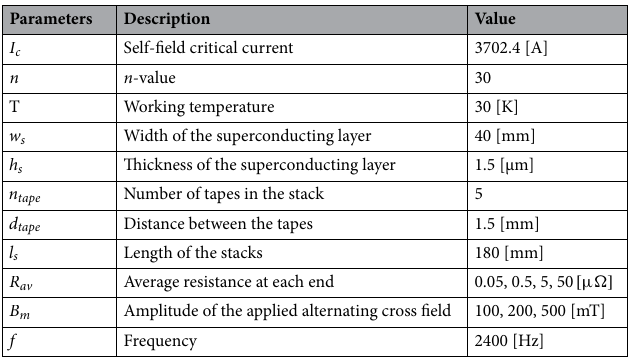
Table 1. The specific parameters of the superconducting stacks used for the calculations. The assumed critical current is lower or equal to extrapolated results in 44 at 25 K and magnetic fields below 1 T.